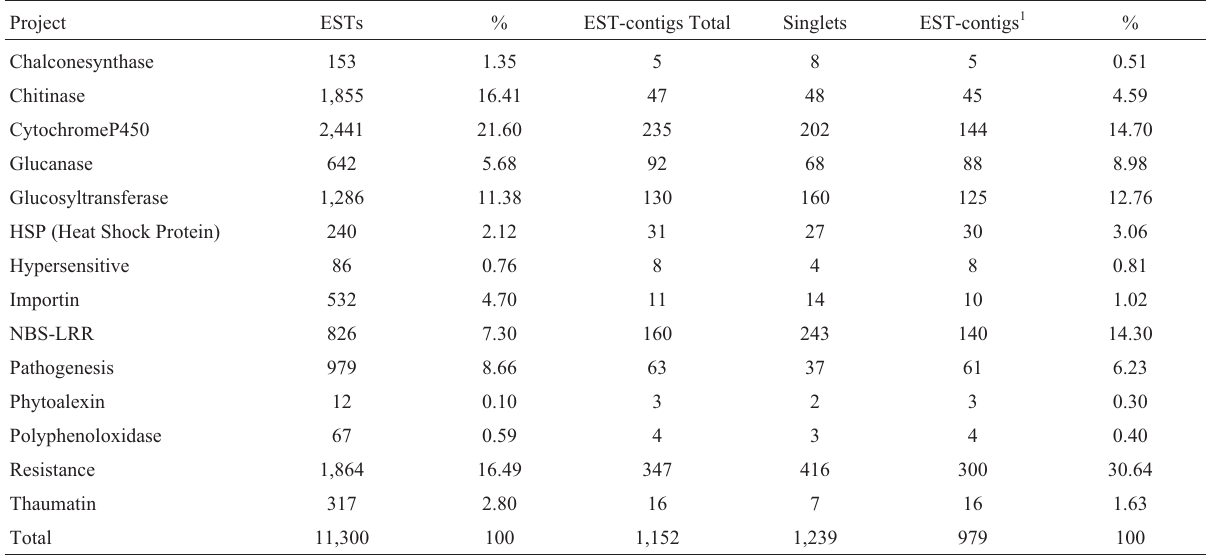
Table 1 - The number of ESTs and their relative percentages obtained by keyword data mining in 14 keyword projects, the number of clusters (EST-contigs and singlets) formed and the number and percentage of EST-contigs with E-values < e -20 and scores > 100.